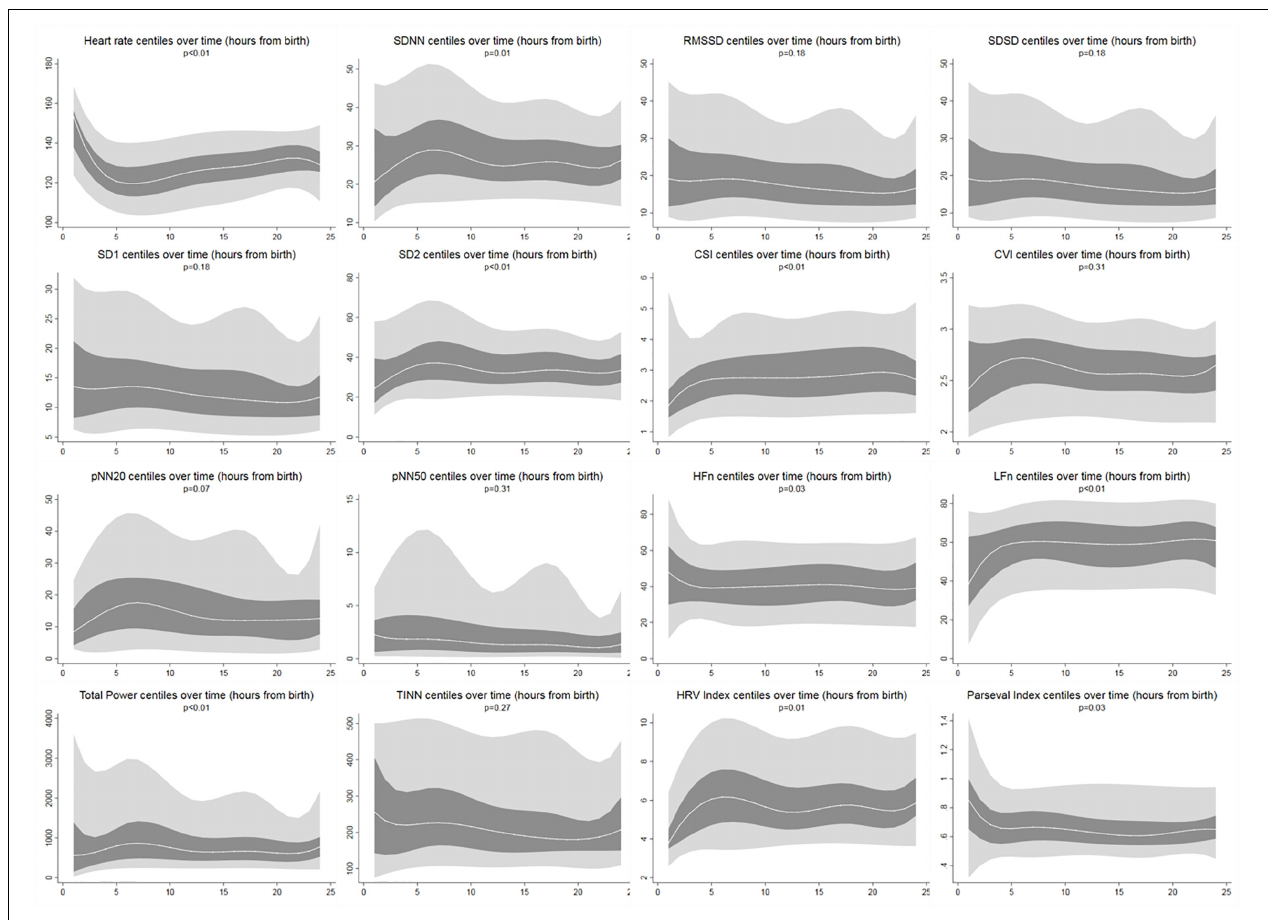
FIGURE 3 | HRV centiles during the first 24 h of age. Light gray areas: 5th–25th centiles and 75th–95th centiles. Dark gray areas: 25th–75th centiles. Middle white line corresponds to the median. Reported p -values result from multi-level mixed effects regression to measure change over time [autoregressive covariance (time), repeated measures (id)]. All centiles smoothed with cubic